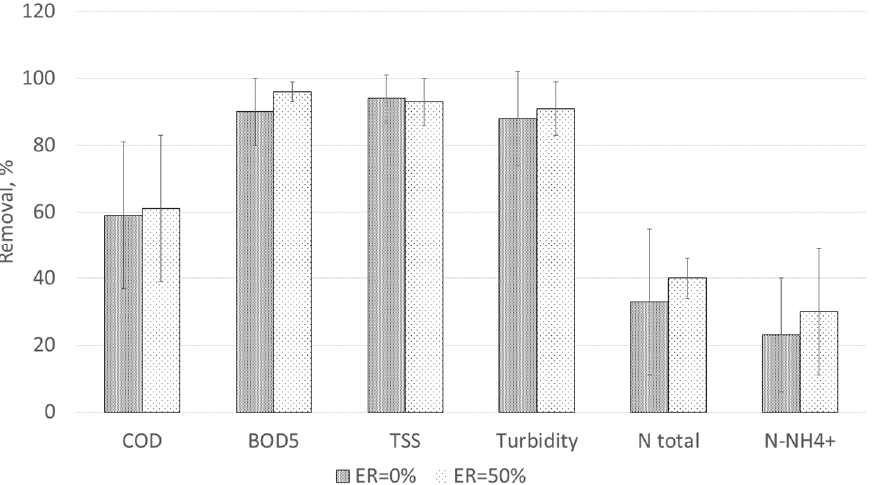
Figure 3. Average removal of conventional parameters without and with 50% effluent recircula- tion.